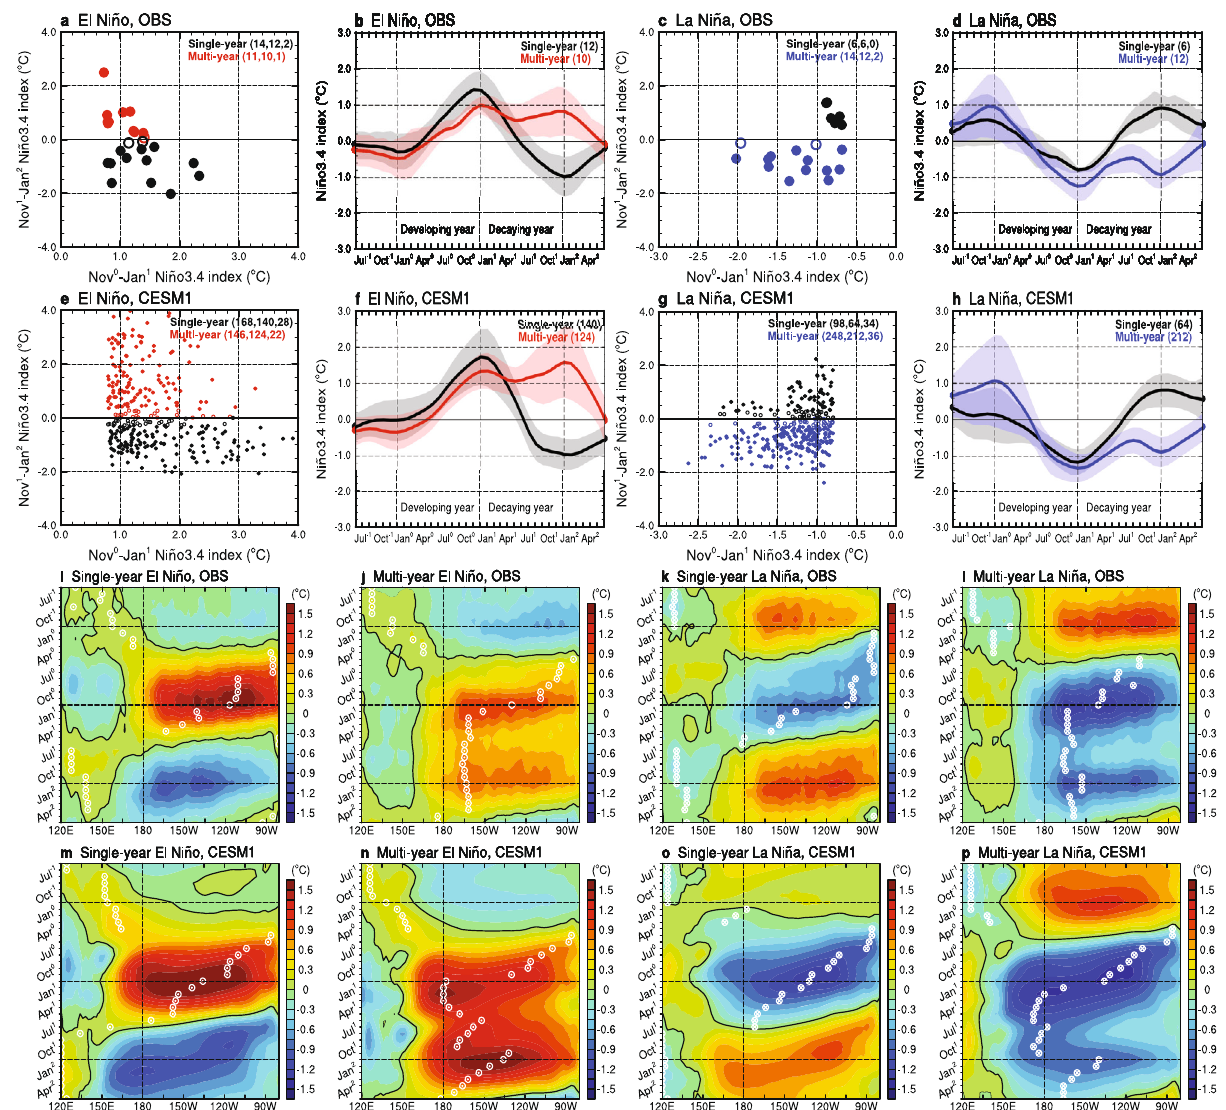
Fig. 1 Spatiotemporal evolution characteristics of single- and multi-year ENSO events. a Scatter plot of the 1 st - winter Niño3.4 index values against their 2 nd -winter values for the El Niños in the observations. Black and red dots respectively indicate the events classi fi ed into single- and multi-year events (see Methods). The events selected for and excluded from composite analysis are expressed as closed and open dots, respectively. The numbers of total, selected, and excluded events are shown in parenthesis. b Temporal evolutions of the Niño3.4 index for the selected single (black curve) and multi (red curve)-year El Niños with their ±1 standard deviations shaded. c , d Same as a , b except for single- and multi-year La Niñas with their multi-year events expressed in blue. e – h Same as a – d , respectively, except for the ENSO events in the CESM1. Longitude-time plot of equatorial (i.e., 5°S ‒ 5°N) Paci fi c SSTAs for the selected i single-year El Niño, j multi-year El Niño, k single-year La Niña, and l multi-year La Niña. The black contours denote zero lines and the white dots mark the longitudinal locations of maximum SSTAs for El Niños (circled dot) and La Niñas (crossed dot). m – p Same as i – l , respectively, except for the ENSO events in the